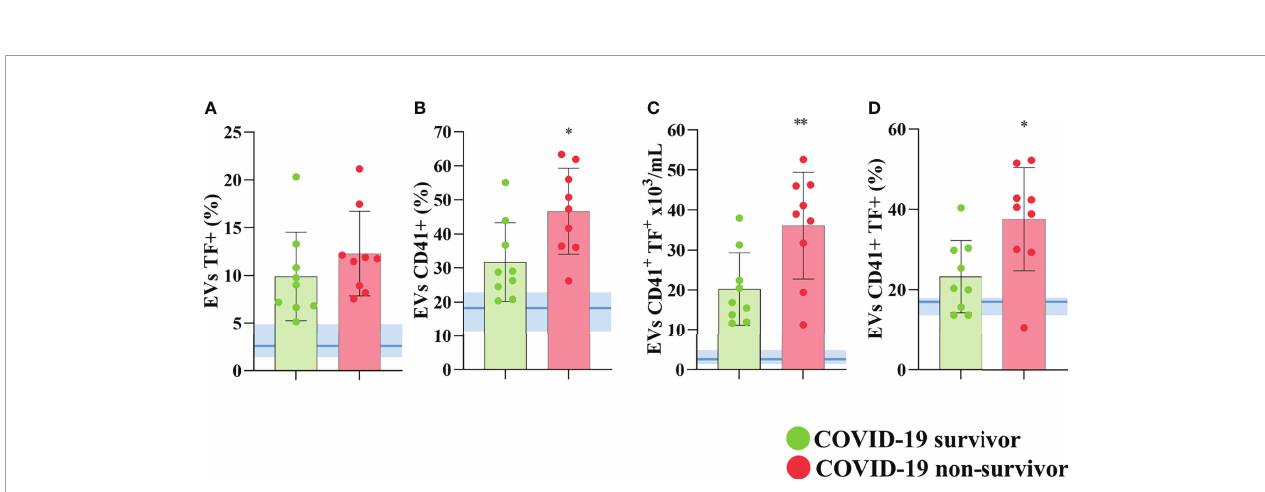
FIGURE 3 | TF-bearing platelet-derived EVs correlates with poor outcome in COVID-19 patients. The percentage of total circulating (A) and platelet derived EVs (B) of COVID-19 survivors and non-survivors. The concentration of TF-bearing platelet-derived EVs (C) and the percentage of platelet-derived EVs expressing TF (D) are shown for covid survivors and non-survivors. Medians with interquartile range are shown. Individual values for COVID-19 survivors (green dots), and COVID-19 non- survivors (red dots) are shown. The blue line and shade indicate the median and interquartile range of the healthy donor. *p<0.05 and